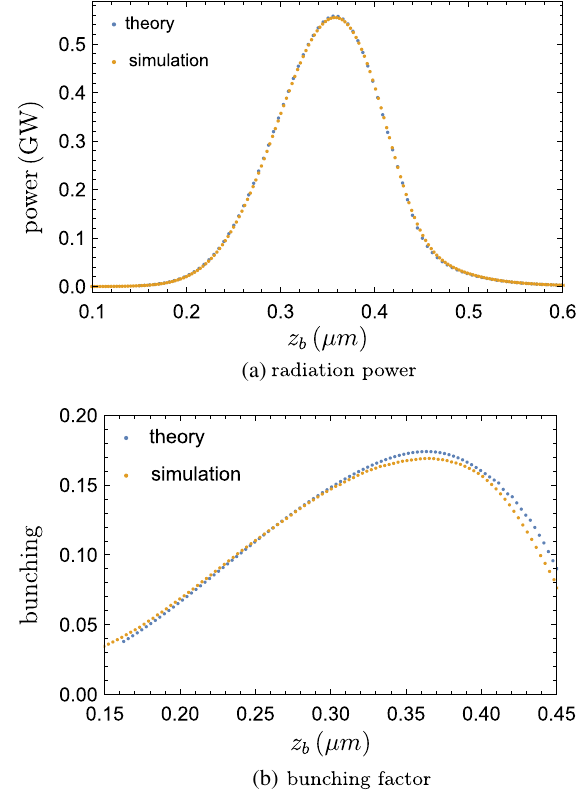
FIG. 2. Shot-averaged radiation power and bunching factor along the e-beam (case A: z ¼ 11 . 45 m, 0 . 50 μ m bunch length, σ ¼ σ 160 nm, Δ E ¼ 30 MeV, 400 shot average, matched θ =k r ¼ linear chirp). The blue/brown curves represent theory/simulation